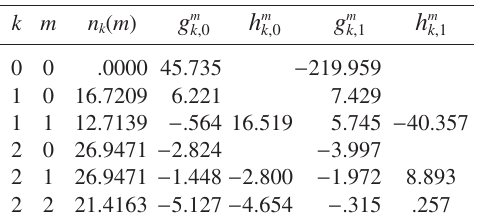
Table I. Coefficients of the Albanian Geomagnetic Reference Model developed by SCHA.